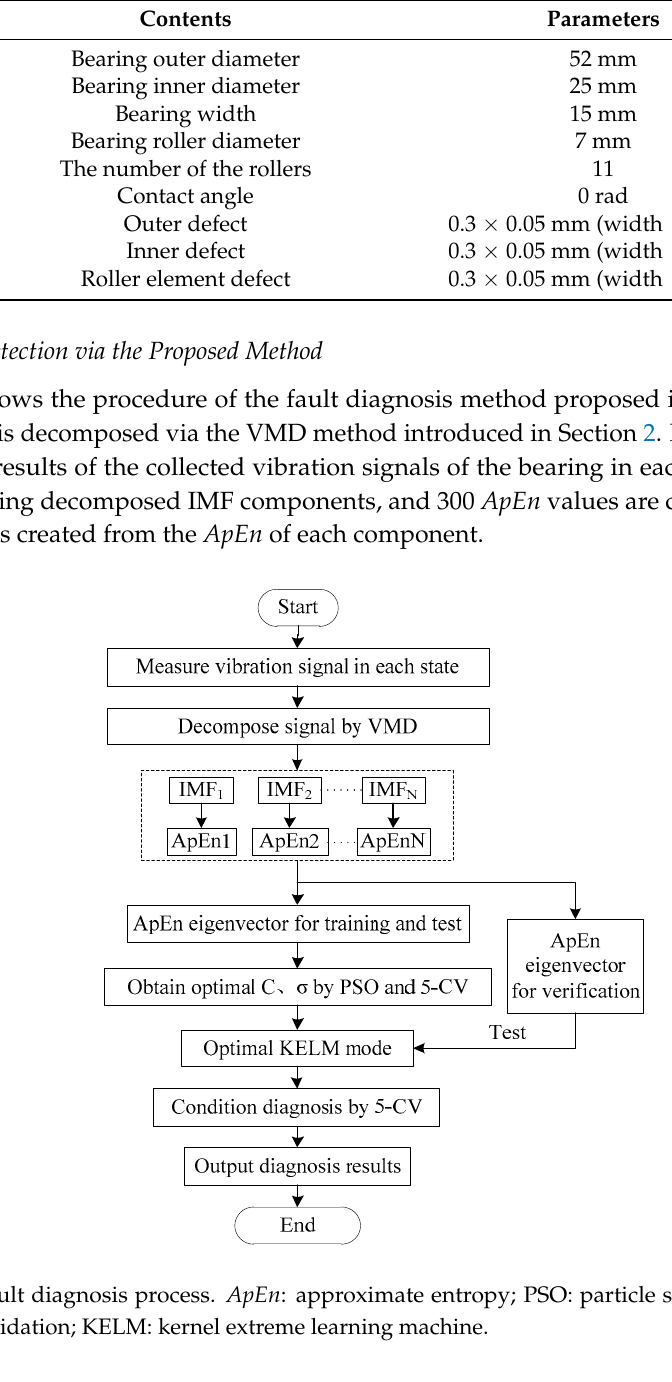
Figure 10. Normal state signal VMD. Figure 11. Outer ring defect state signal VMD.